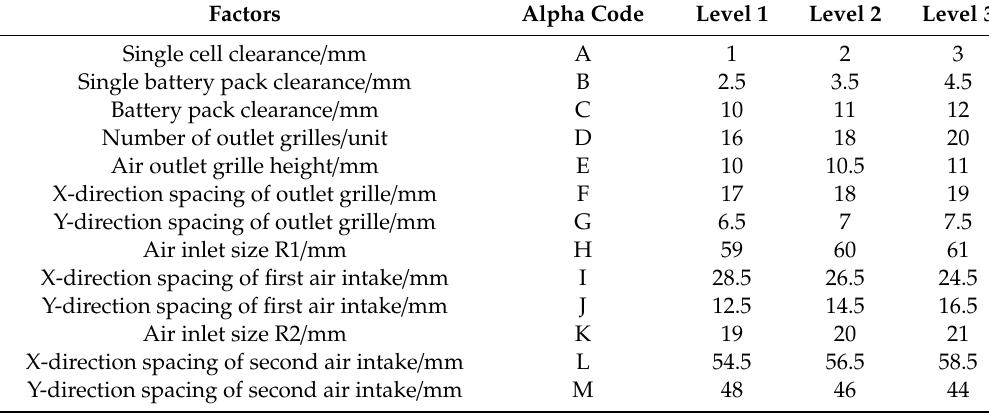
Table 2. Factors of the Formula Electric Vehicle (FEV) air cooling system orthogonal test scheme level.